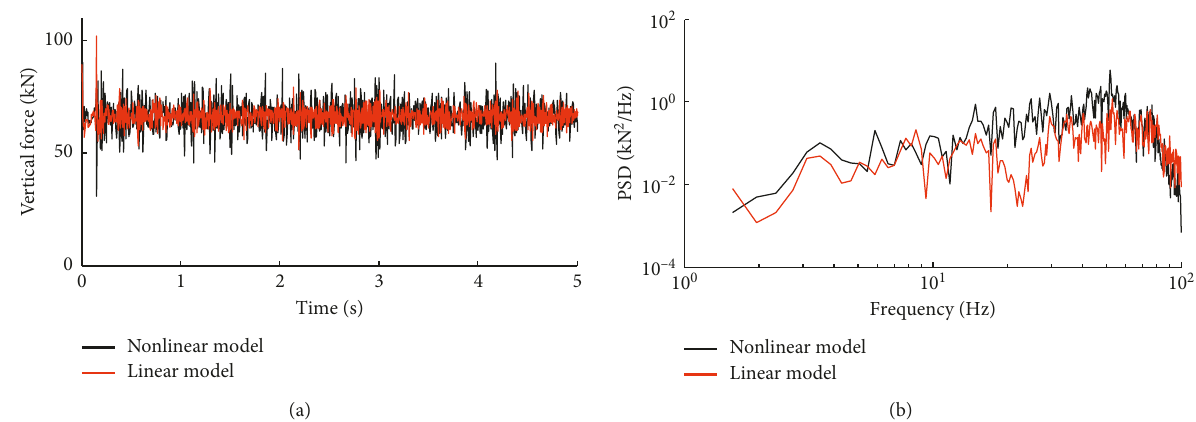
Figure 5: Comparison of the wheel-rail vertical force between the linear model and the nonlinear model in the (a) time domain and (b) frequency domain.